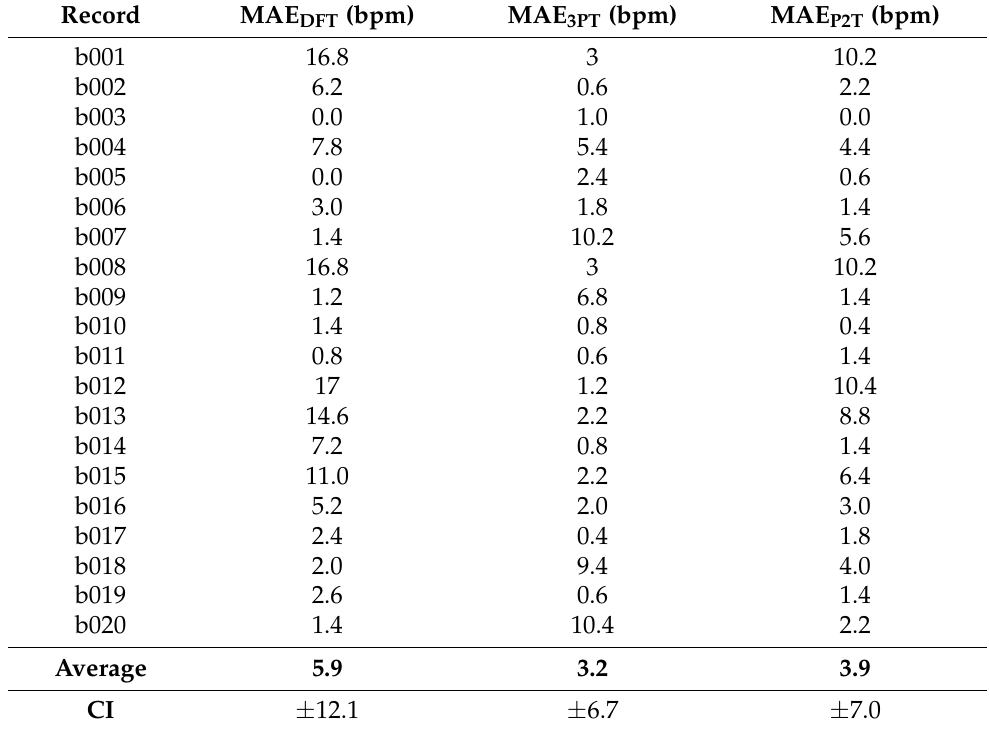
Table 1. S1-S1 interval